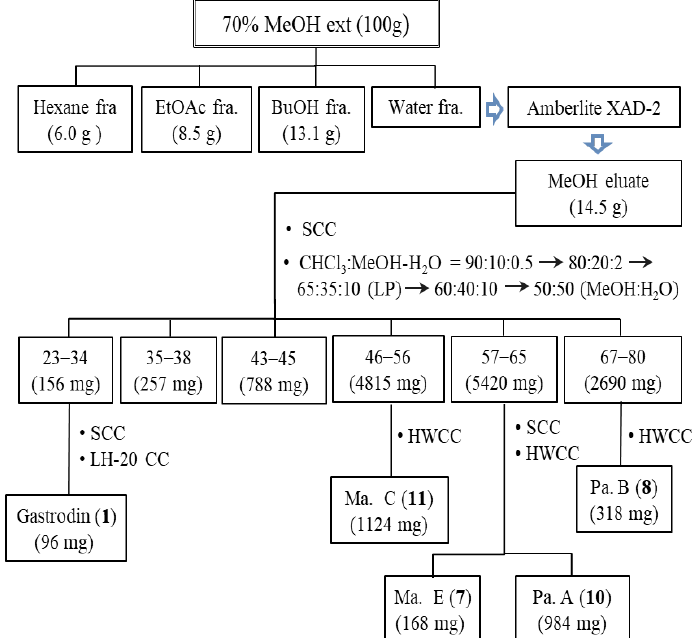
Molecules 2022 , 27 , x FOR PEER REVIEW Scheme 1. Isolation of parishin and its derivatives from M. tricuspidata twig. SCC, silica gel column chromatography (CC); HWCC, Toyopearl HW-40S CC; pa, parishin; Ma, macluraparishin. Compound 1 (peak no. 1 in Figure 3E) was isolated as a white amorphous powder.